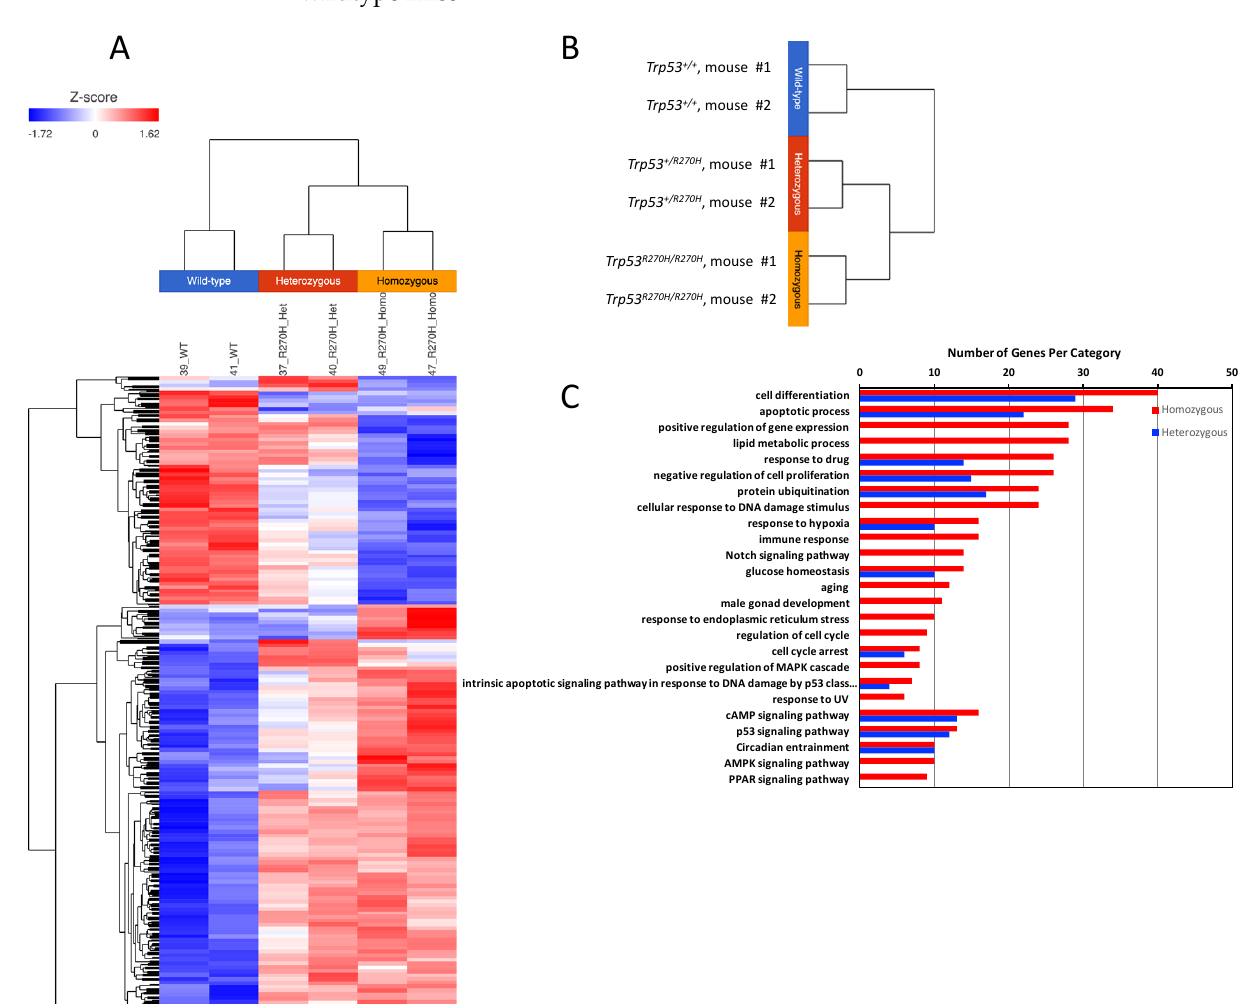
Figure 2. RNA-seq analysis demonstrates that presence of the Trp53 R270H mutant allele is able to alter the transcriptional response of prostate cells to 5 Gy radiation . A distinct difference in gene expression patterns was observed between wildtype mice ( Trp53 +/+ ) versus heterozygous mice ( Trp53 +/R270H ) and between wildtype mice ( Trp53 +/+ ) versus homozygous mice ( Trp53 R270H/R270H ); heatmap ( A ), hierarchical clustering ( B ), and gene ontology ( C ) analyses. Differences between heterozygous and homozygous mice were also